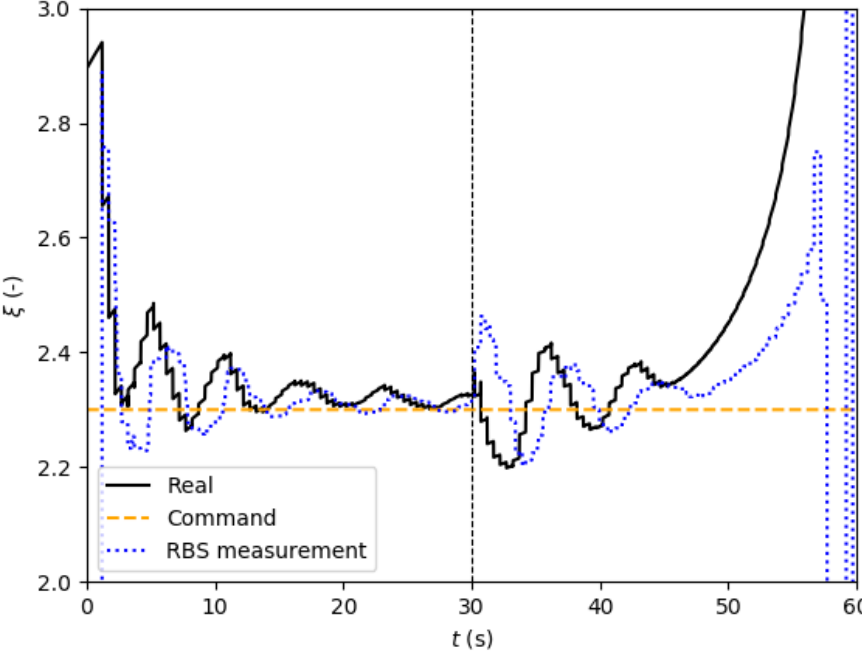
Figure 26. Mixture ratio profile, feedback with downgraded regulation law, case 2.